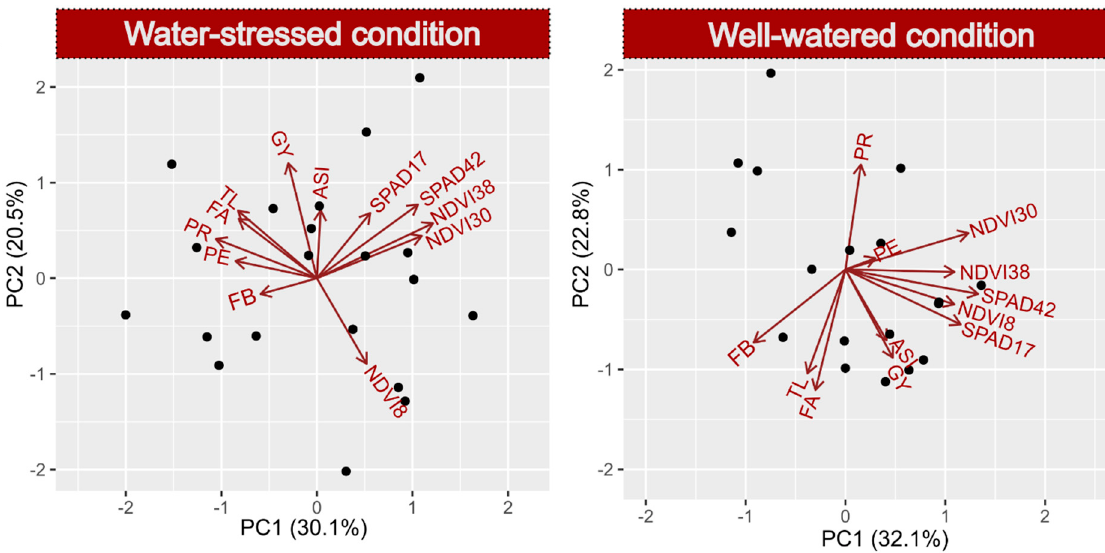
Figure 1. PCA-biplot constructed with traits with significant influence on the response variable grain yields (GY) and popping expansions (PE), selected by multiple regression analyses of the morphological traits (PR = prolificacy, TL = tassel length, TB = number of tassel branches, ASI = anthesis-silking interval, FA = leaf angle and FB = leaf rolling); SPAD index (17 and 42 days after male flowering) and Normalized Difference Vegetation Index (8, 30 and 38 days after male flowering), estimated for 20 popcorn inbred lines under water stress and well-watered conditions.